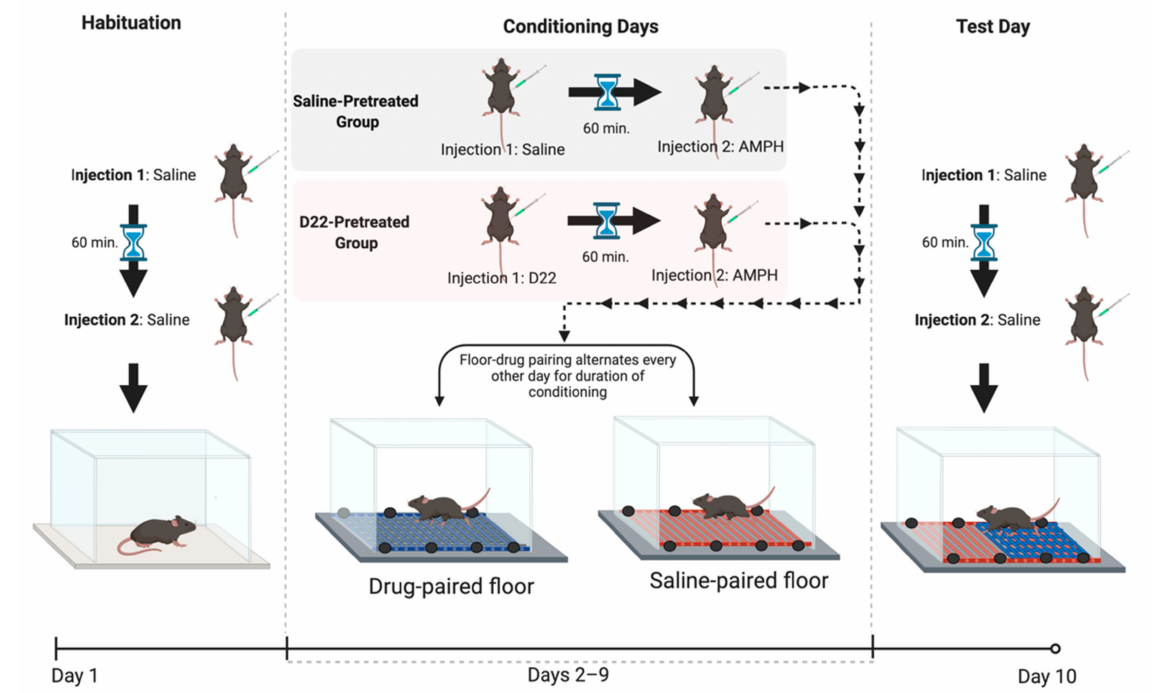
Figure 5. Schematic of conditioned place preference procedure (CPP). The CPP procedure consisted of three phases: habituation (one session), conditioning (eight sessions), and place preference test (one session). Immediately before each daily session, each animal received an intraperitoneal injection of saline or 0.1 mg/kg decynium 22 (D22), followed 60 min later by a second injection of saline or 1 mg/kg amphetamine (AMPH). After the second injection, mice were immediately placed in the center of the apparatus. For the habituation session, all mice received saline and were placed in the apparatus for 30 min (min) on a floor covered with paper. Thirty minute conditioning sessions were held on the following 8 days. Conditioning consisted of pairing one floor type with the injection of amphetamine and the other floor type with the injection of saline. The day after the last conditioning session, the 30 min floor preference test, using a floor in which each half consisted of each floor type, was conducted in mice having received saline. Place preference was measured by subtracting the amount of time spent on the drug-paired floor from the amount of time spent on the saline-paired floor. Figure created with